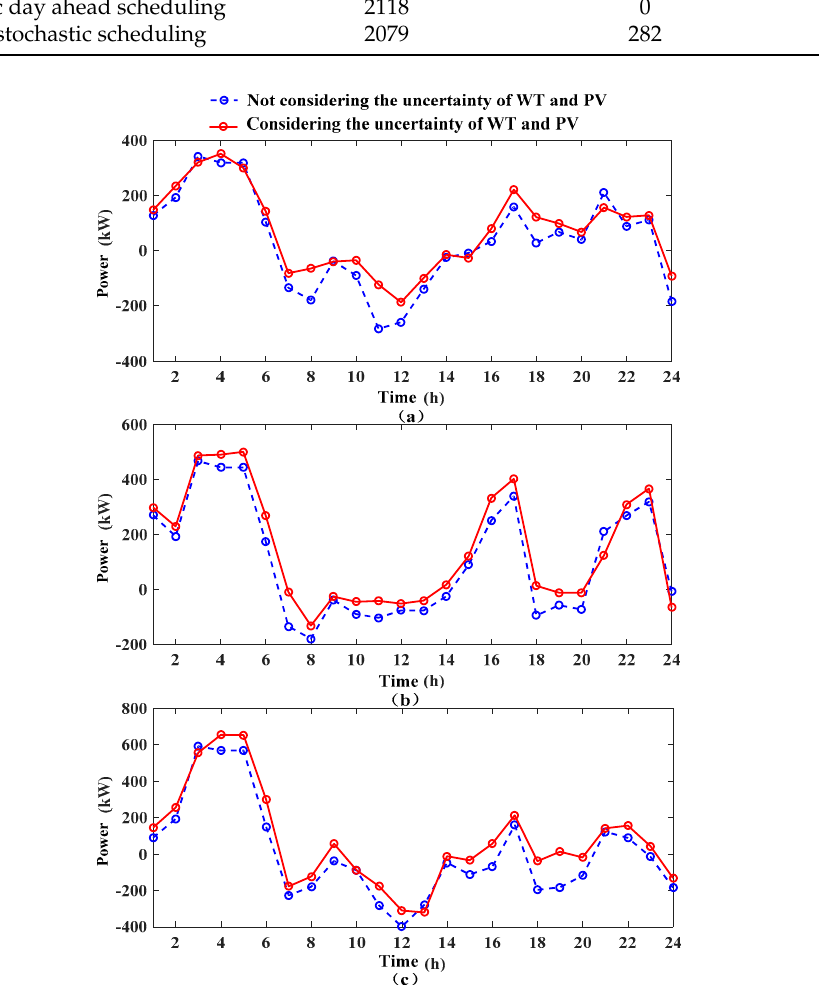
Figure 4. The interactive active power of the ADN and VPPs ( a ) VPP 1-ADN; ( b ) VPP 2-ADN; ( c ) VPP 3-ADN.